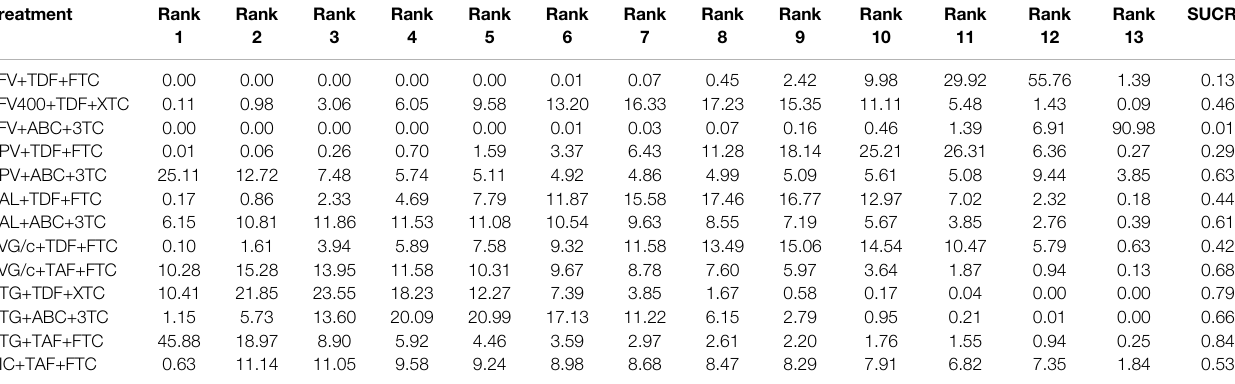
TABLE 2 | Possibility of each treatment in each rank and the SUCRA value for each treatment for the virologic suppression outcome at 48 weeks. Treatment Rank